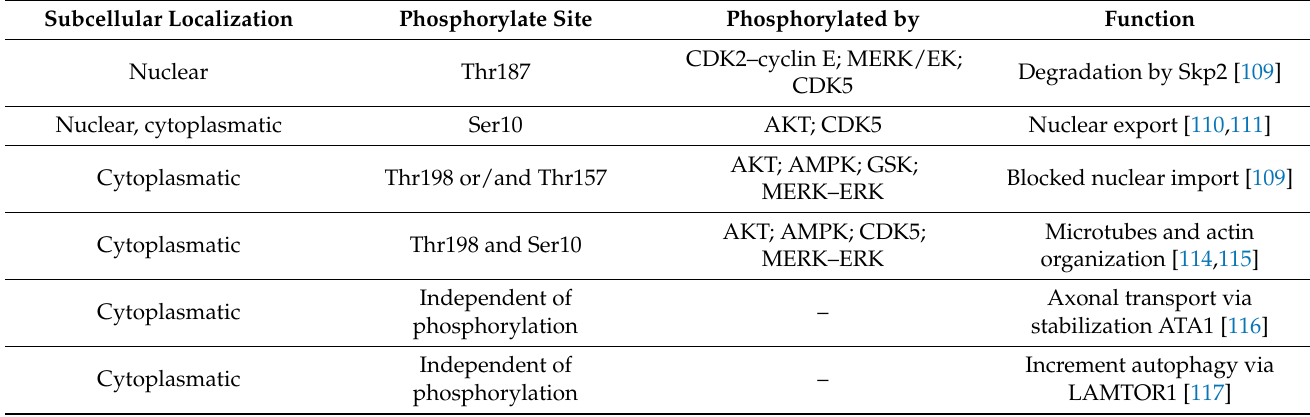
Table 1. Phosphorylation sites of p27 Kip1 : its role in cellular localization and